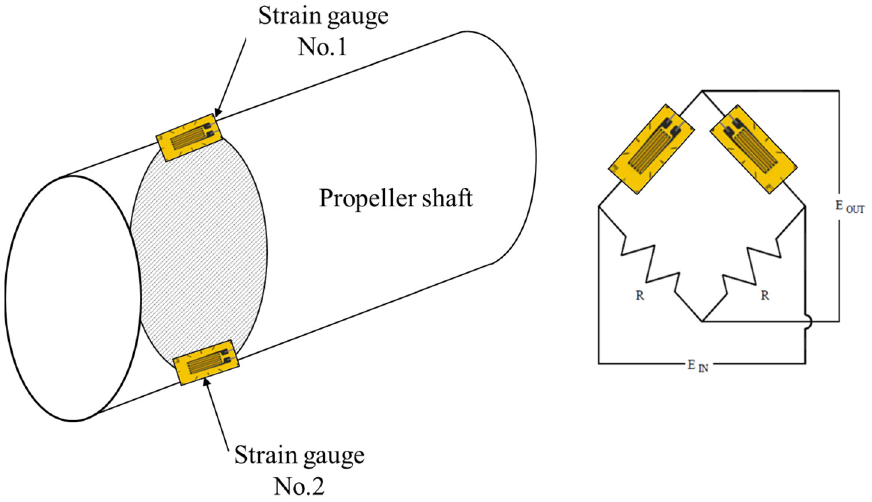
Figure 3. Typical half-bridge strain gauge circuit configuration.